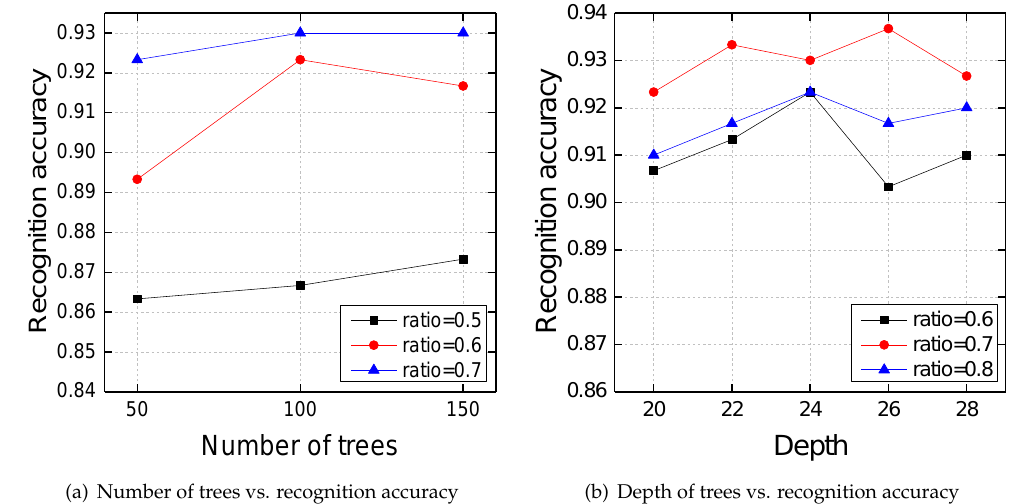
Figure 6. Recognition accuracy on the UT-I #1 dataset using different training